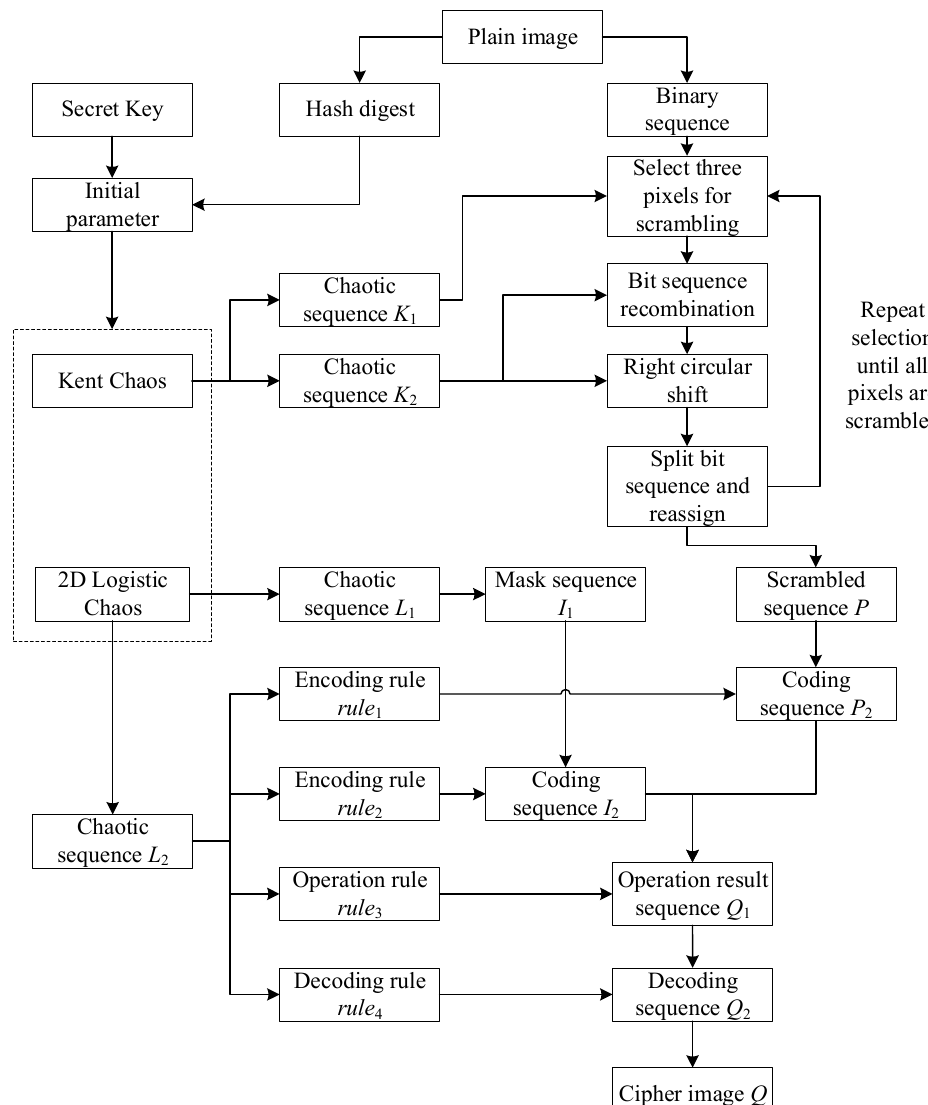
G Table 2. The rules of DNA operation. Addition